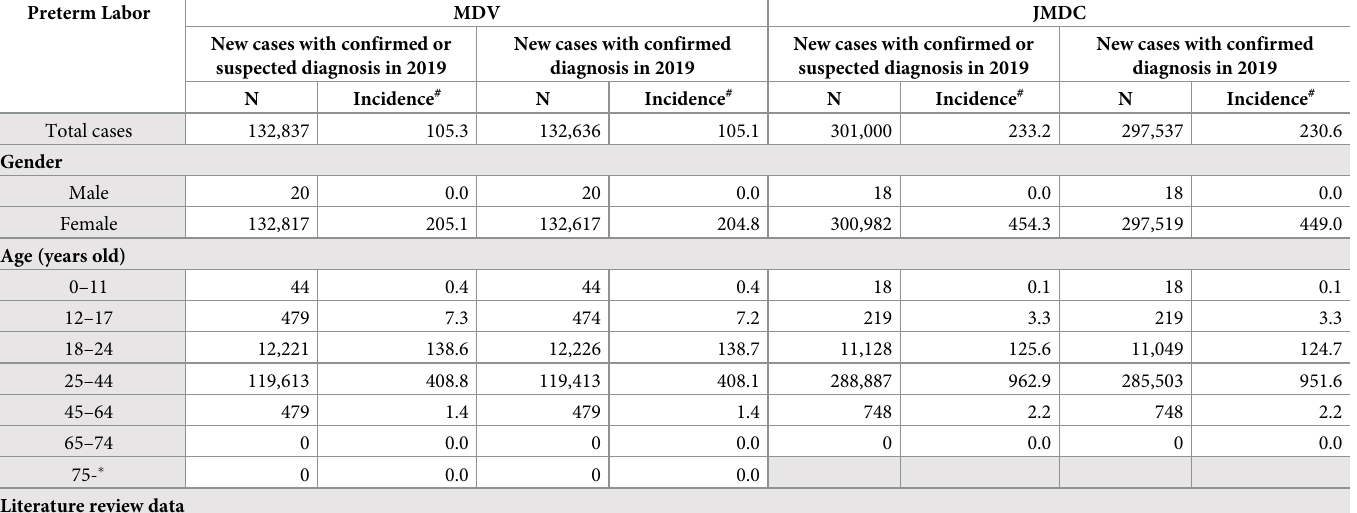
Table 15. Estimated incidence of Preterm